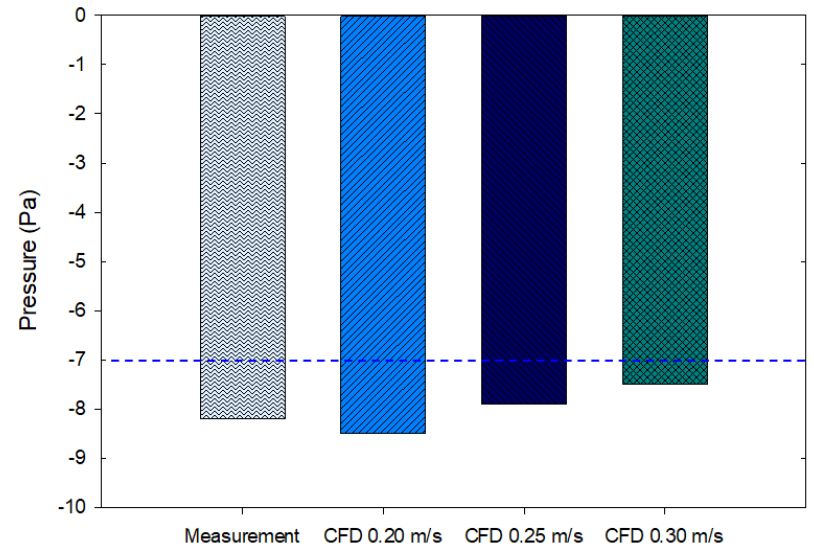
Figure 11. The pressurization results in different cases.